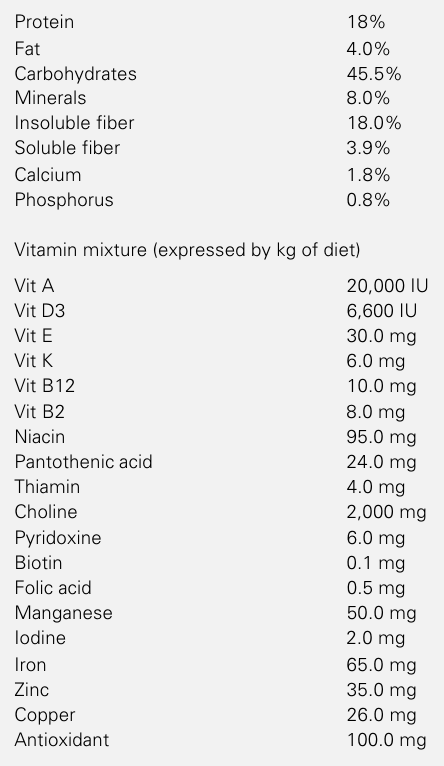
Table 1 - Basic composition of the regular diet.